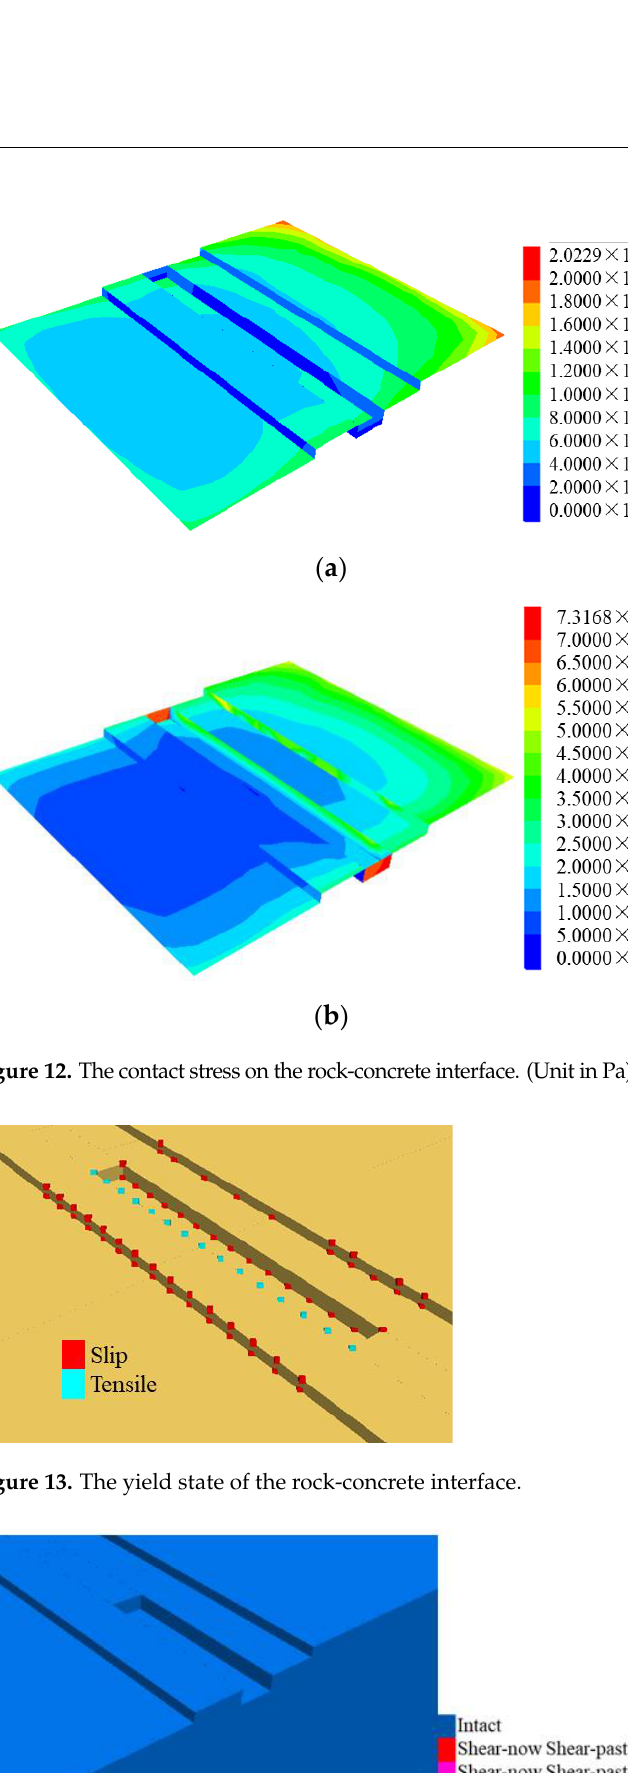
Figure 13. The yield state of the rock-concrete interface.